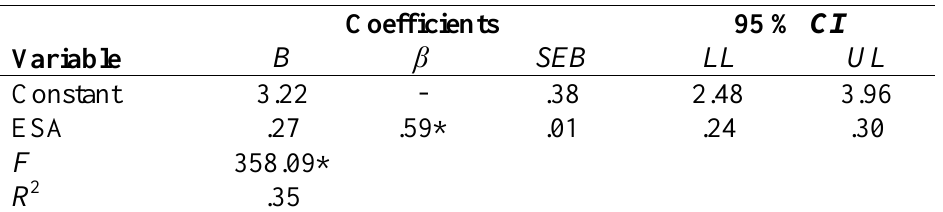
Table 4 Effectiveness of scenario-based assignment as a predictor of student-instructor interaction Coefficients